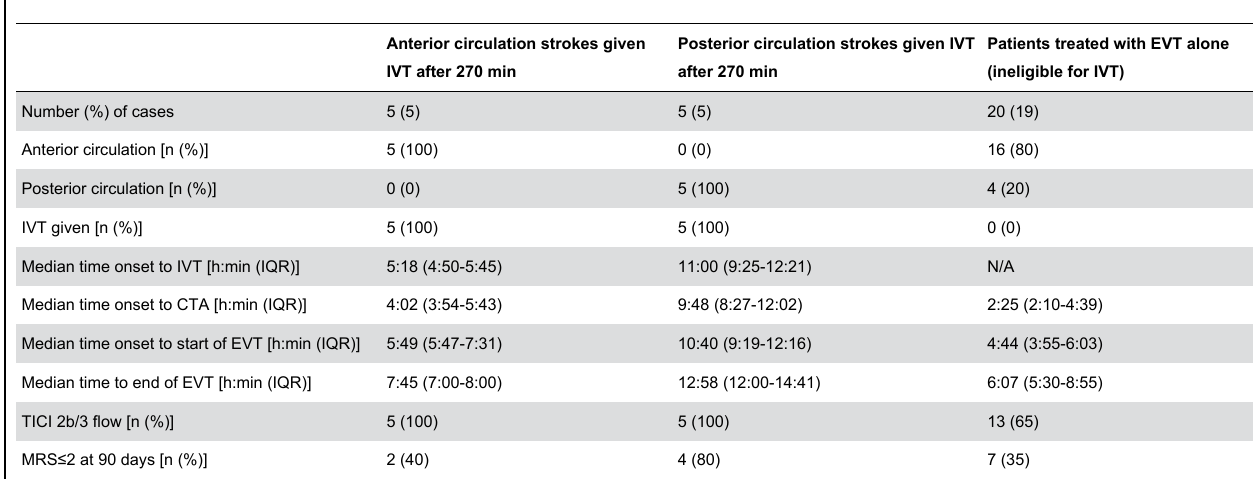
Table 5. Outcomes for patients treated with late intravenous thrombolysis or with endovascular treatment alone.